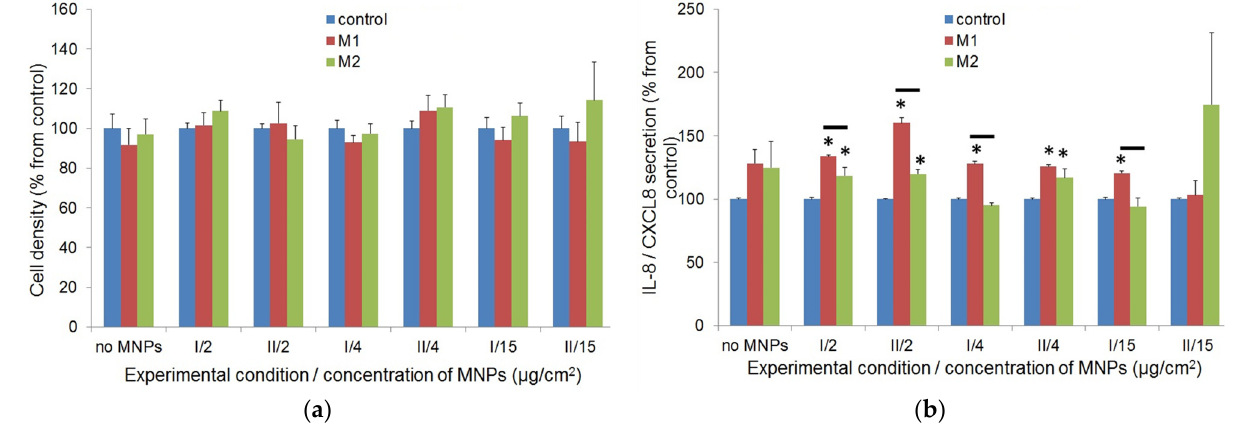
Figure 7. ( a ) Fibroblasts proliferation activity with application of the constant magnetic field at var- ious concentrations of MNPs. Cells were seeded with uptaken nanoparticles (condition I), or MNPs were added to growth medium after fibroblasts seeding (condition II). Fibroblasts were incubated outside magnet or exposed to M1 and M2 magnetic field. For every MNPs concentration, the data were normalized to the cell monolayer density in the absence of magnetic field (accepted for 100%). No statistically significant differences in proliferation between cells exposed to constant magnetic field and control were found at all MNPs concentrations. ( b ) IL-8/CXCL8 secretion by fibroblasts with application of the constant magnetic field. For every MNPs concentration, the data are normal- ized to secretion level in the absence of magnetic field (accepted for 100%). Values that are statisti- cally different from control ( p < 0.05) are indicated by asterisks; significant differences between M1 and M2 are indicated by lines.